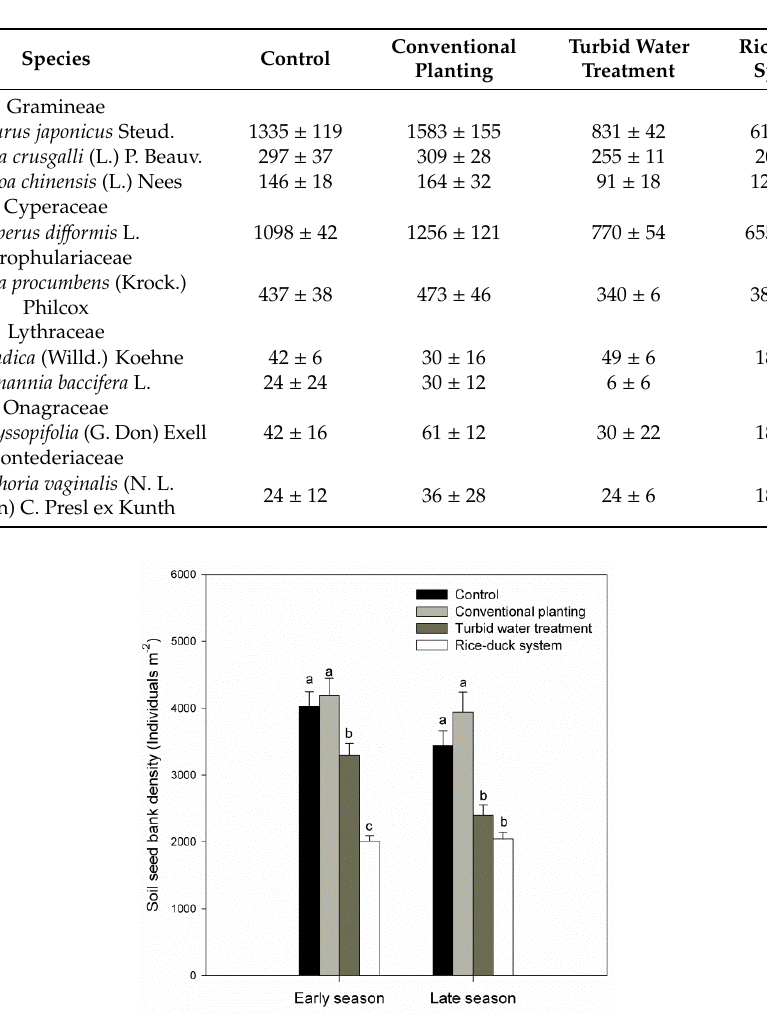
Table 2. Soil seed bank composition (individuals m − 2 ) under di ff erent treatments in the late season of rice growth.